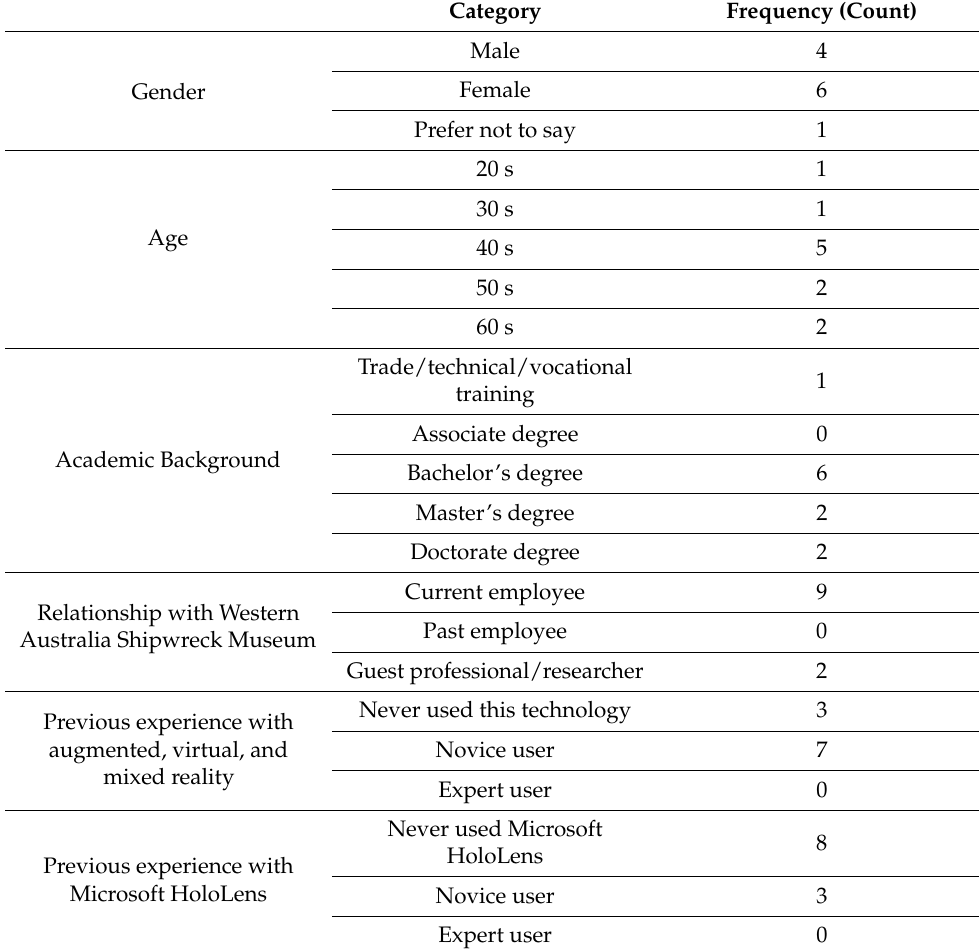
Table 2. Demographic characteristics of participants ( n = 11).